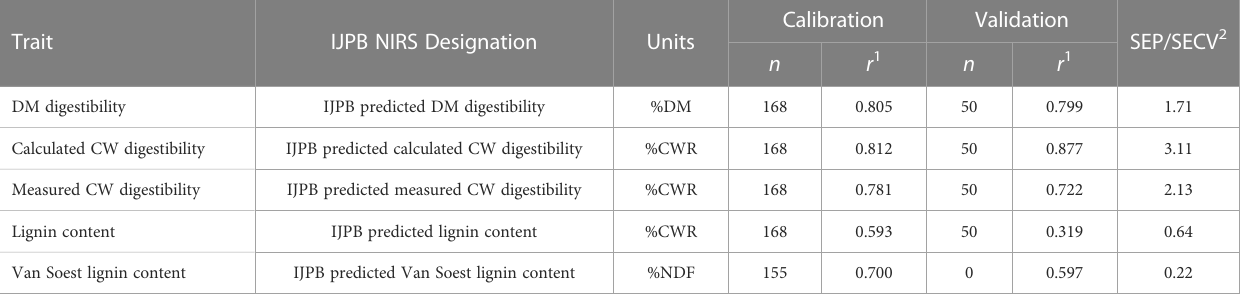
TABLE 1 DM and CW-related features measured in the laboratory, with their associated NIRS prediction equation features for the IJPB equation.